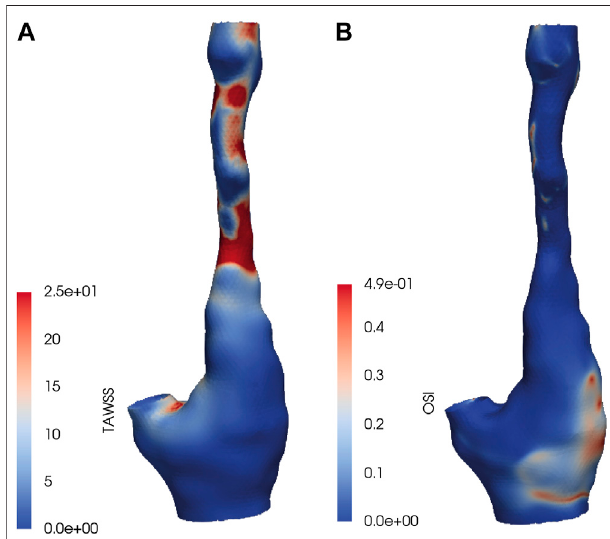
FIGURE 1 | (A) Time-averaged wall shear stress (TAWSS) and (B) oscillatory shear index (OSI) values on a carotid bifurcation included in the dataset.